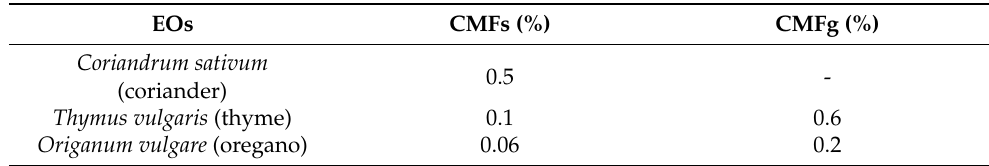
Table 4. Fungistatic and fungicidal effect of the analysed EOs on Fusarium graminaerum expressed as minimum concentration with fungistatic effect (CMFs) and minimum fungicidal concentra- tion (CMFg).